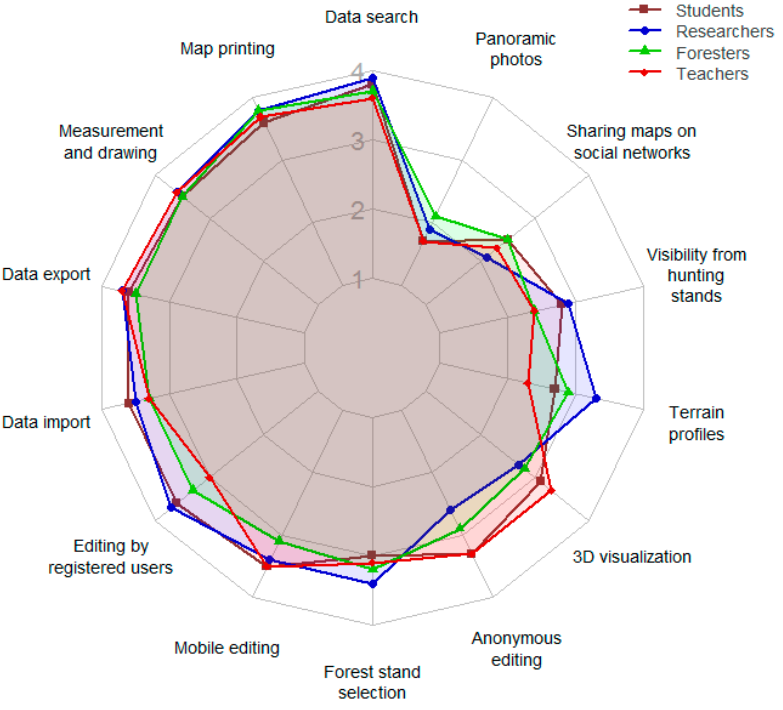
Figure 4. Importance of GIS tools (1—very low importance, 4—very high